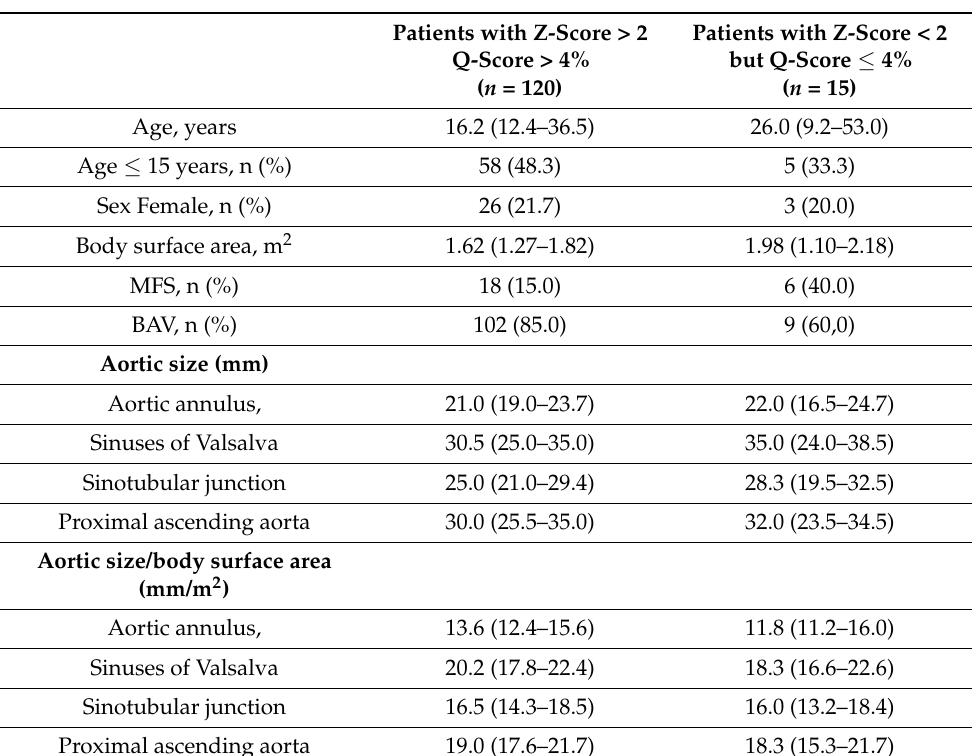
Table 5. Demographic and clinical characteristics of 135/466 discordant deemed-at-risk subjects based on BAV or MFS. Patients with Z-Score >